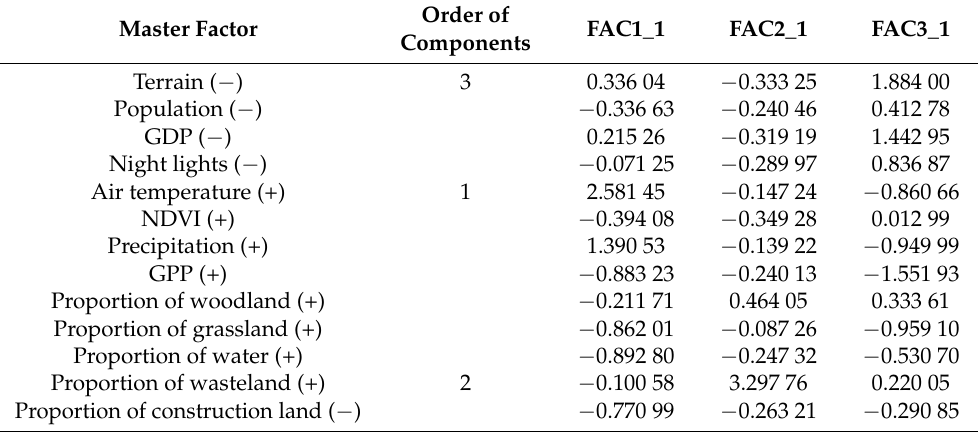
Table 5. Main control factors in